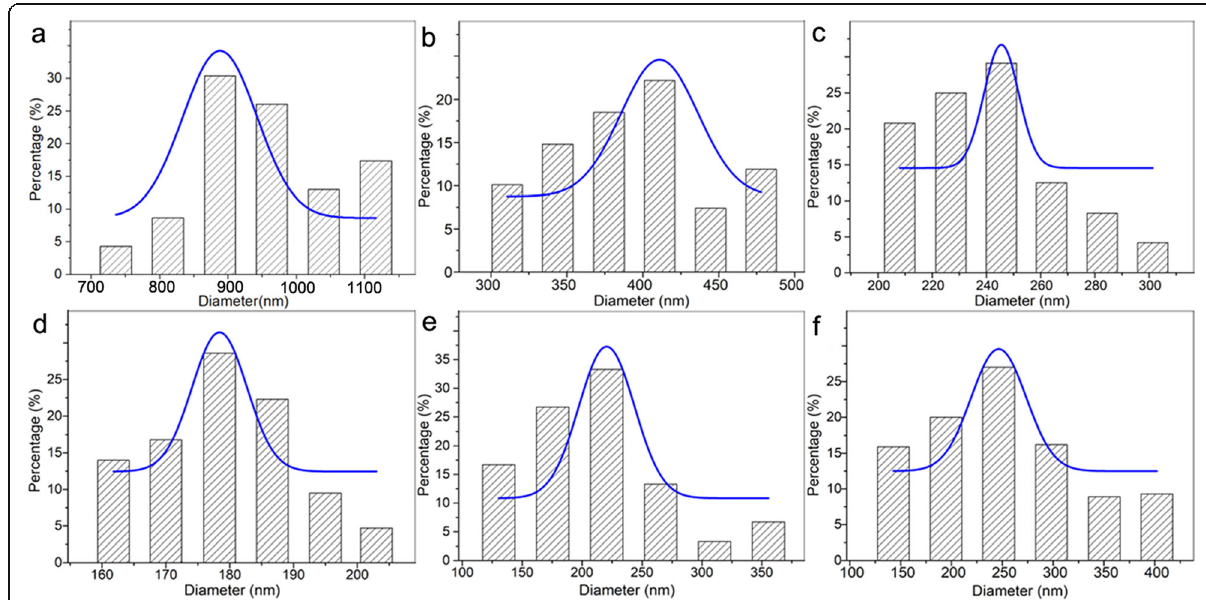
Fig. 6 The diameter distribution of PVDF-HFP nanofiber under different voltage value a 6 kV, b 10 kV, c 15 kV, d 20 kV, e 25 kV, and f 30 kV